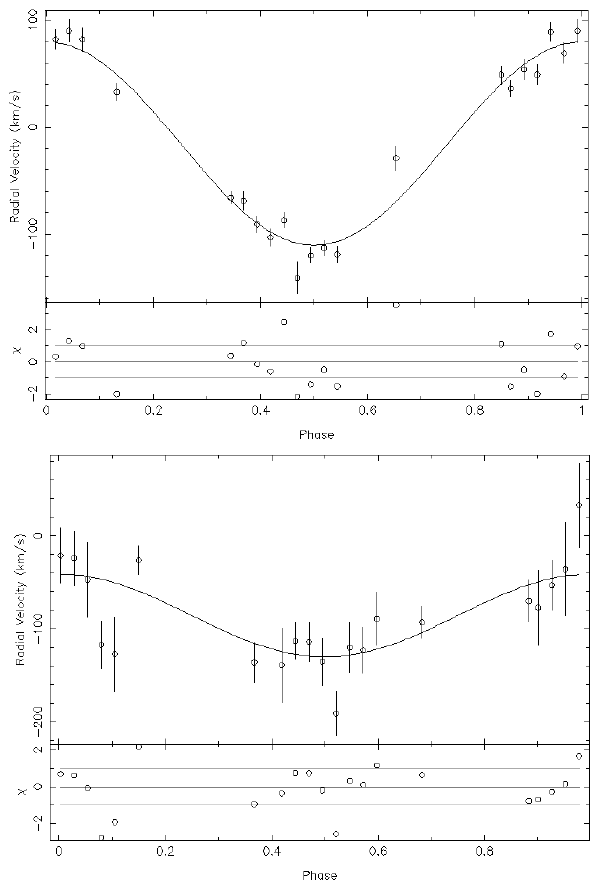
Figure 1. RV of PTF1 J0113 plotted against its orbital phase. The up- per plot shows the RV curve of the blue channel, while in the lower one the curve of the red part can be seen. In the bottom of the fig- ures the residuals are illustrated.